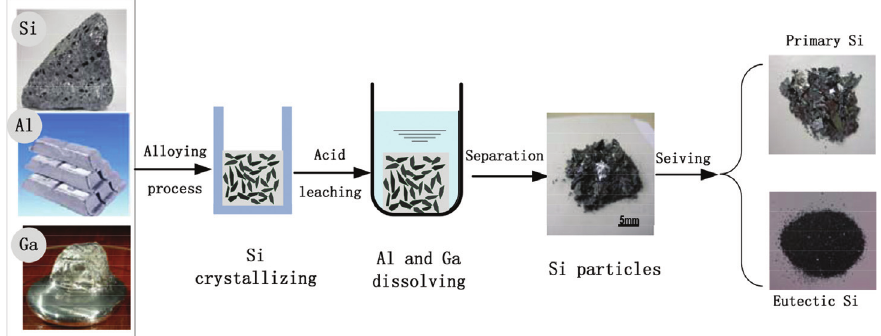
Figure 3: Flowchart of solvent refining process of